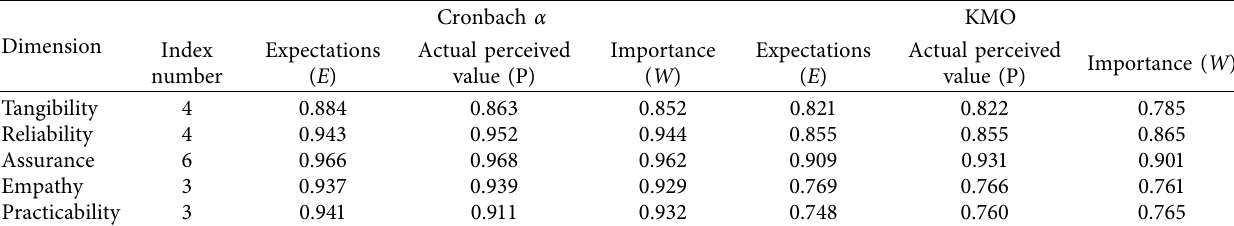
Table 2: The test result of reliability and validity of the